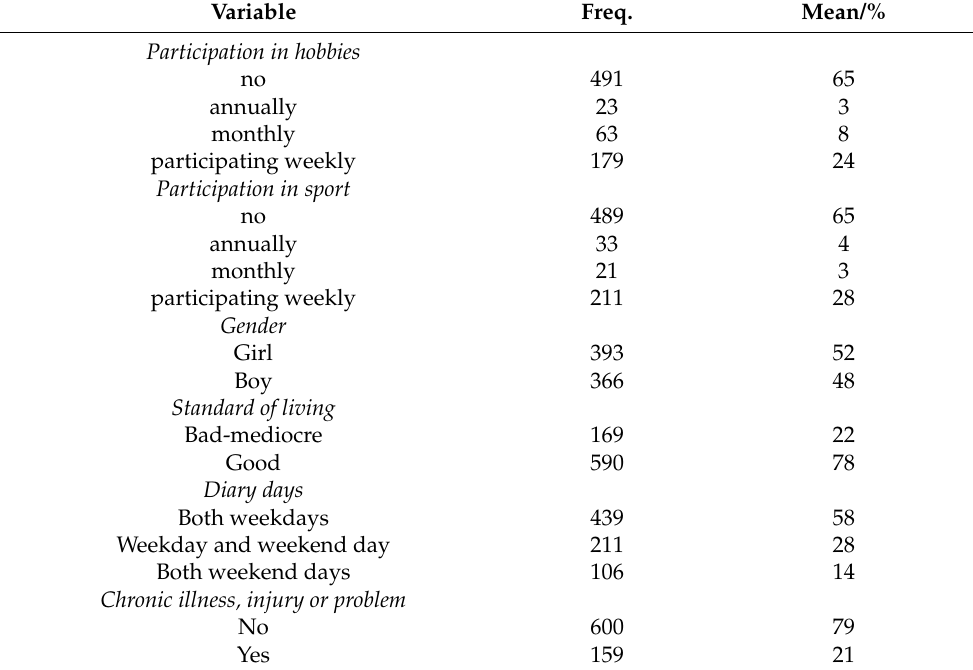
Table 1. Cont. Variable